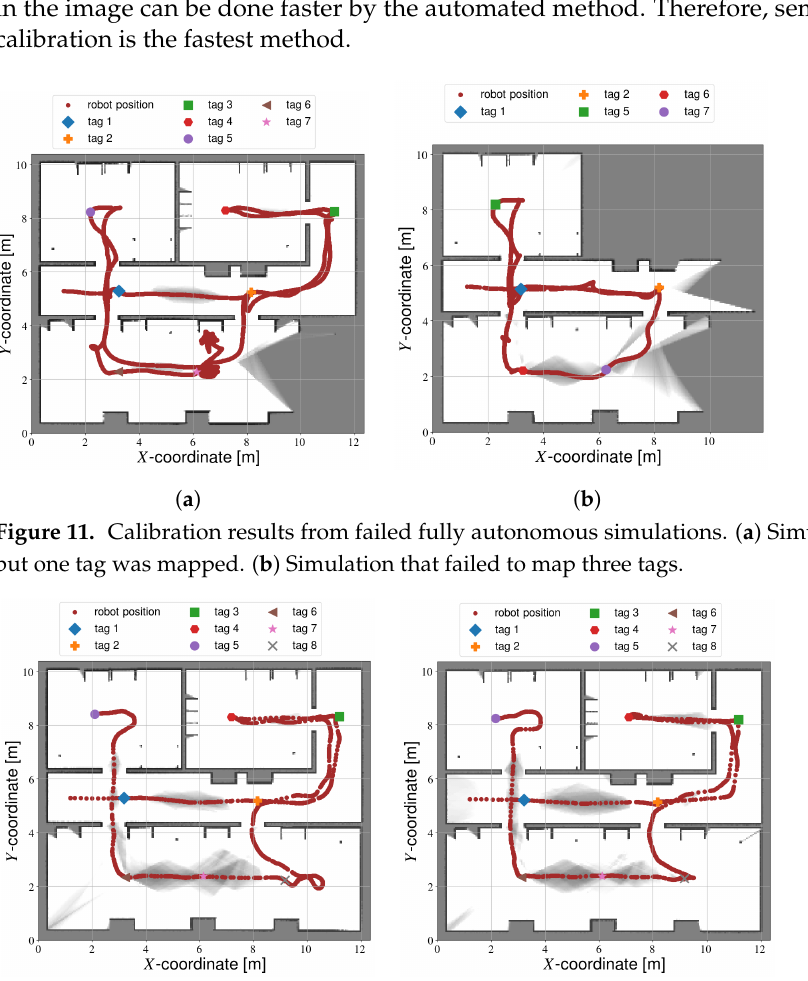
Figure 12. Manual calibration